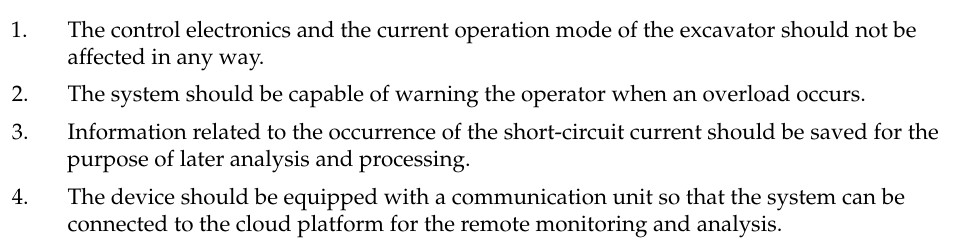
Table 1. Functional requirements for the system design.